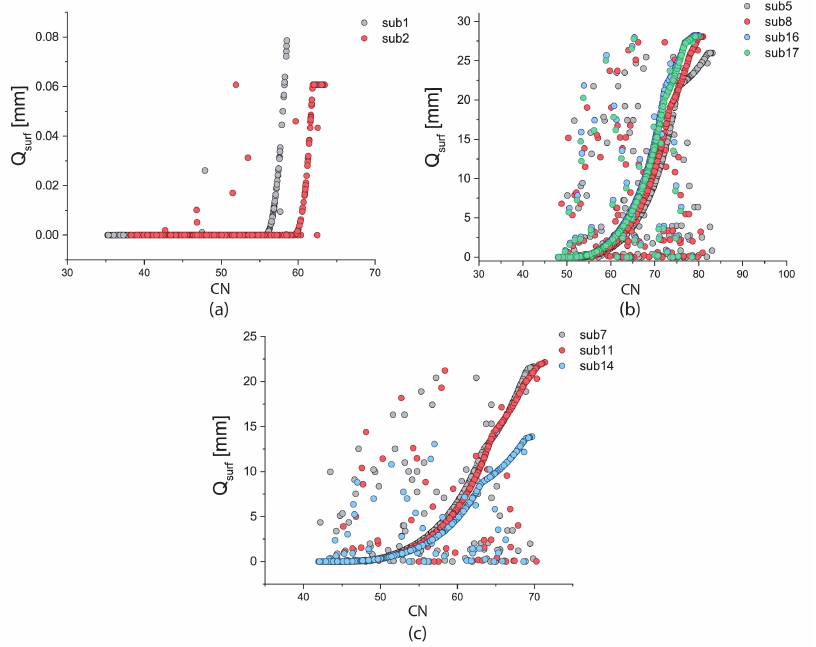
Figure 13. Scatterplot of the average curve number and the maximum runoff for each combination of model parameters for different subbasins: subbasin 1 and 2 ( a ); subbasins 5, 8, 16, and 17 ( b ); subbasins 7, 11, and 14 ( c